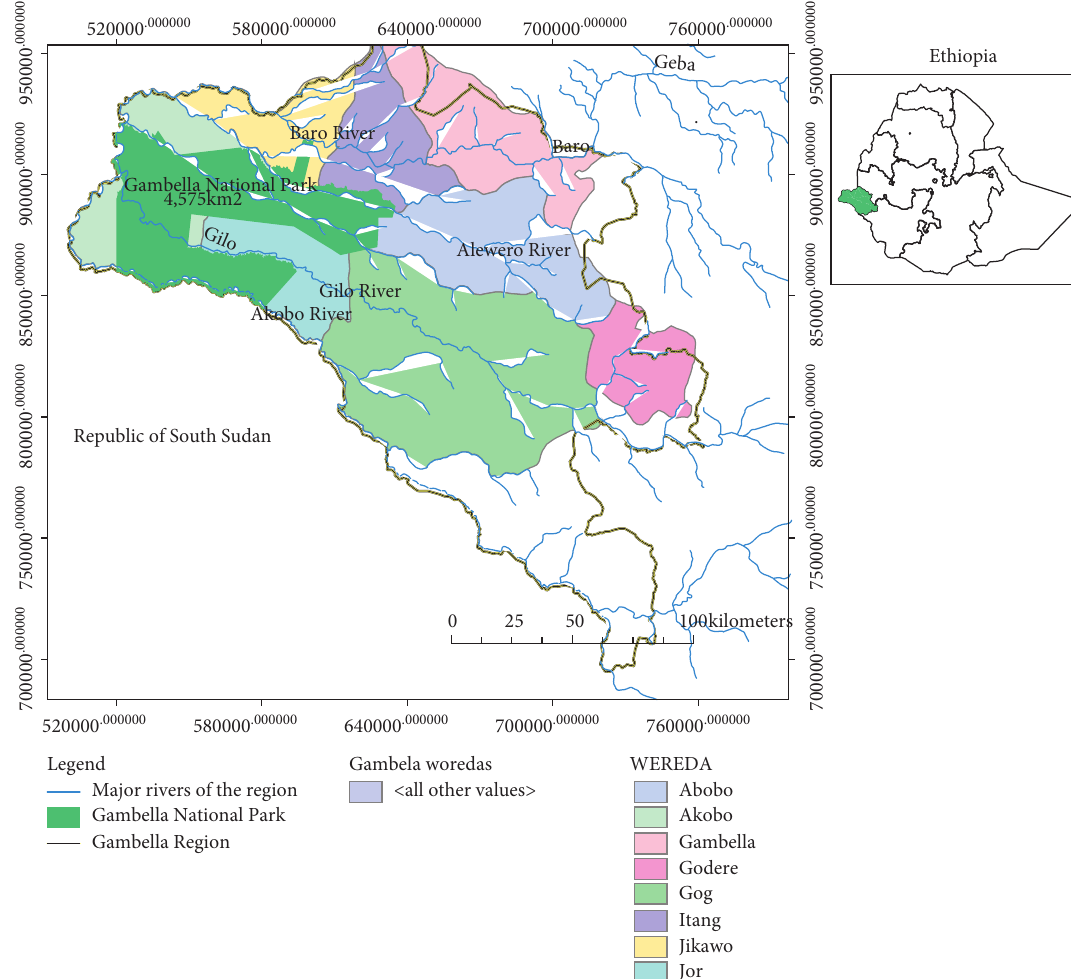
Figure 1: Location of Gambella National Park within Gambella Regional